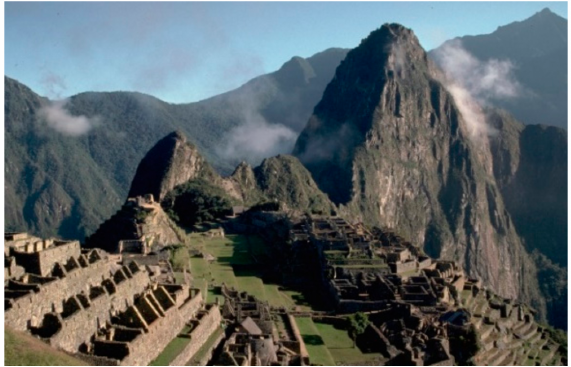
Figure 1. The Machu Picchu site is abutted by the mountains of Machu Picchu and Huayna Picchu. When we think of Machu Picchu, we picture its perfectly battered walls and intricately carved temples, huacas, and niches. While these features, alone, are a testament to the engi- neering skills of the Inca craftspeople, this article explores the water-related infrastructure of Machu Picchu and the remarkable ingenuity and foresight that it demonstrates. Machu Picchu is an unlikely place to construct a royal estate due to its remoteness, geologic faults, water availability, and landslide potential. Built on a ridge between the two mountains of Machu Picchu and Huayna Picchu to house a resident population of 300 and a peak population of 1000, the Inca engineers worked with nature to create a community with a reliable water supply, good storm drainage, flat areas for agriculture, and building foundations that would meet the challenges of steep, unstable slopes and high